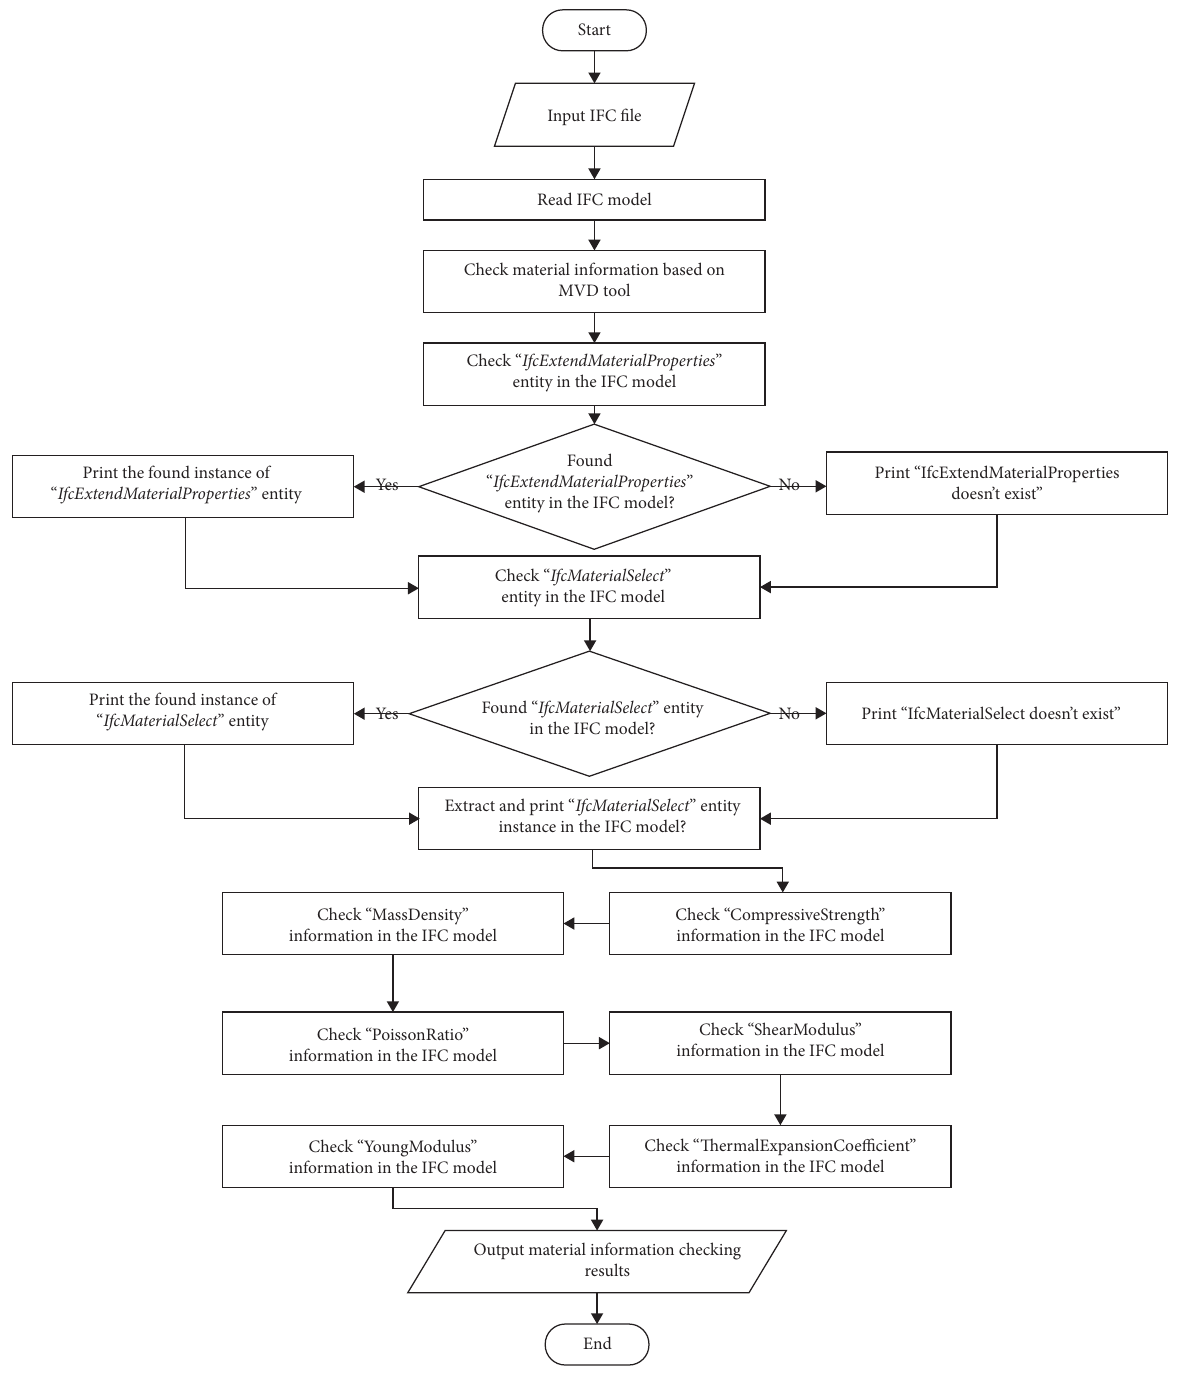
Figure 10: Material information checking algorithm augmenting MVD.